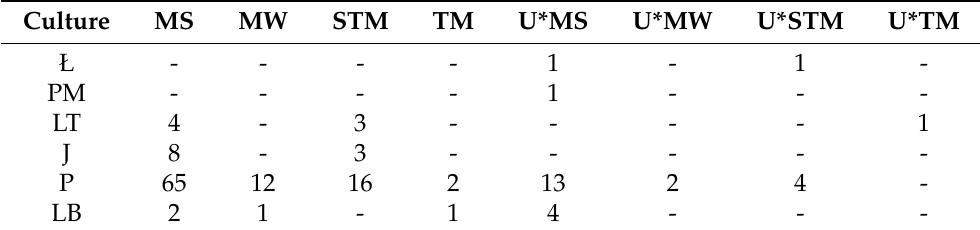
Table 2. Identified settlement points with traces of metallurgy at archaeological sites (MS— Manufacturing settlement; MW—Metallurgical workshop; STM—Settlement with traces of met- allurgy; TM—Traces of metallurgy; U*—Uncertain cultural affiliation) in Lower Silesia within the cultural units: Ł—Łu˙zyckie; PM—Pomorskie; LT—Latenian; J—Jastorskie; P—Przeworskie; LB— Luboszyckie